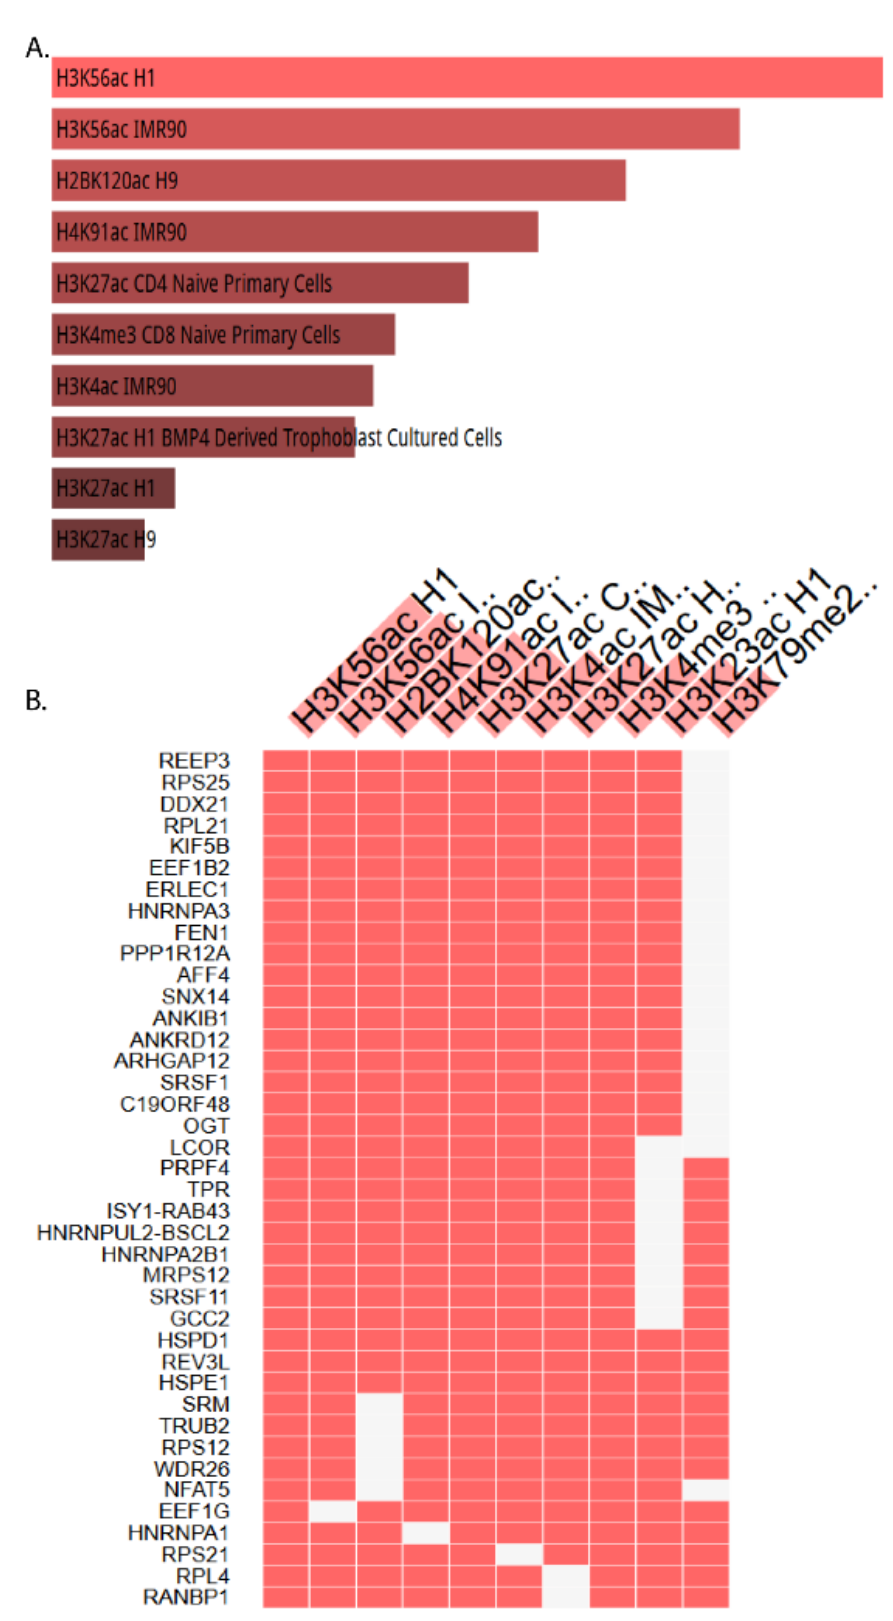
Figure 2. Visualization of the top 40 genes involved in histone modifications ( A ) and epigenomics ( B ) using over-representation analysis. The genes were obtained using ORA analysis, clustered by Enrichr for visualization ( p < 0.05), and isolated according to the ENCODE Histone Modifications gene set library.